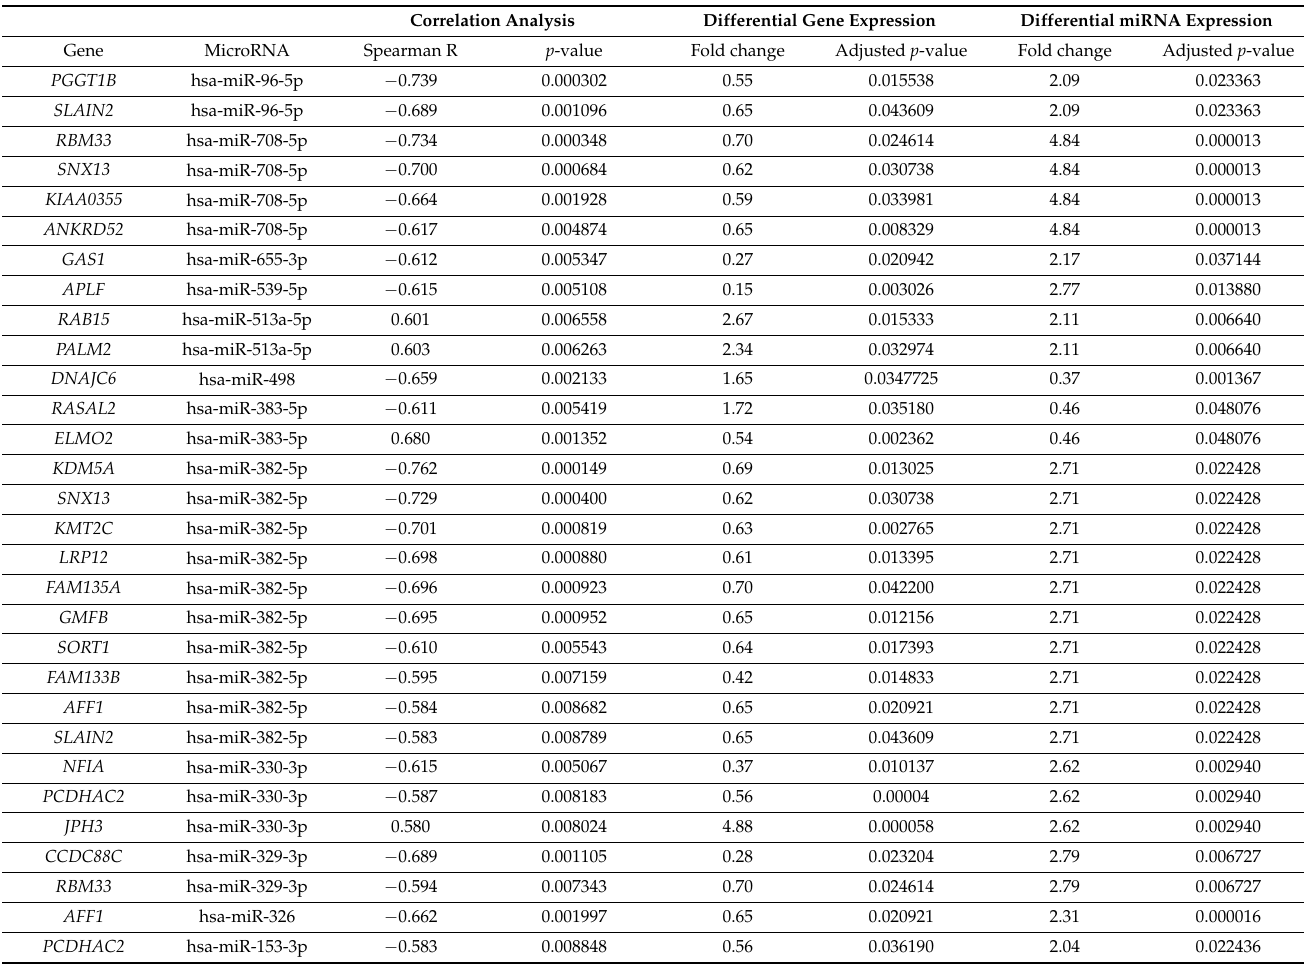
Figure 3. The predicted contribution of differentially expressed miRNAs (DEMs) in differential gene expression. ( a ) The proportion of genes differentially expressed in USP8 mut and USP8 wt corticotroph tumors; ( b ) genes that are putative targets of DEMs. Table 4. Genes with distinct expression levels in USP8 mut and USP8 wt tumors with an expression difference related to the levels of differentially expressed miRNAs .